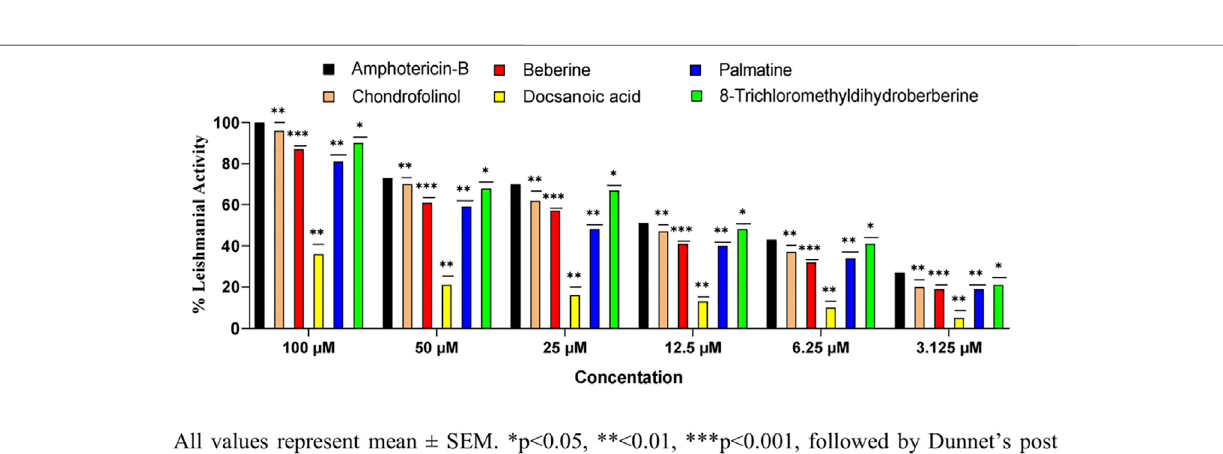
Frontiers in Chemistry |